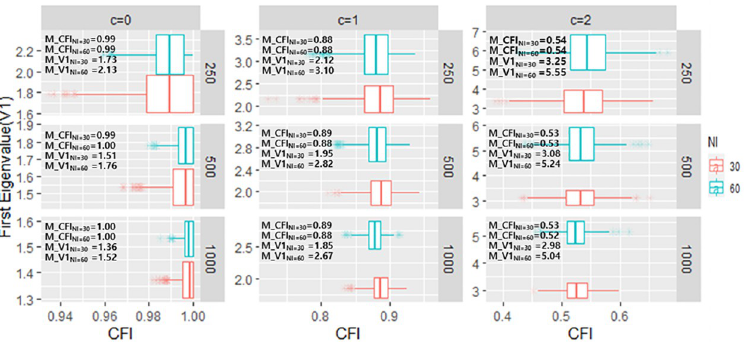
Fig 3. The relationship between first eigenvalue of PCAR and CFI in each TD simulation conditions. ( Note . M: mean of values across simulations).